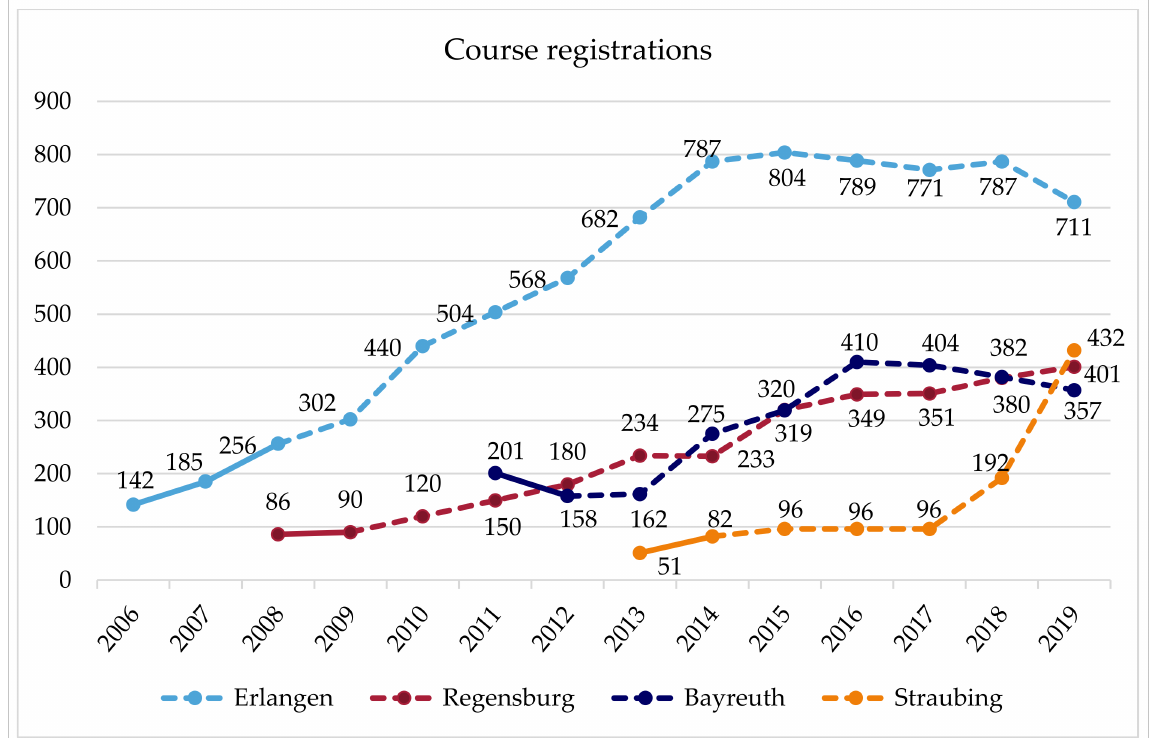
Figure 1. Number of women registering for regular physical activity course offers per year in four communities in Germany.